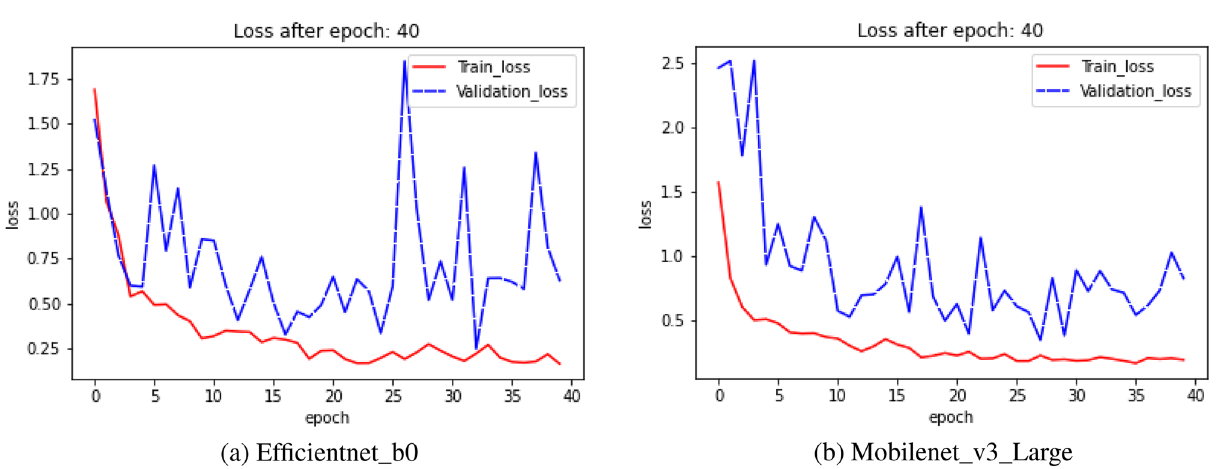
Figure 14. Graph showing the Loss plot generated by: ( a ) Efficientnet_b0 and ( b ) Mobilenet_v3_Large transfer learning models on HuGaDB